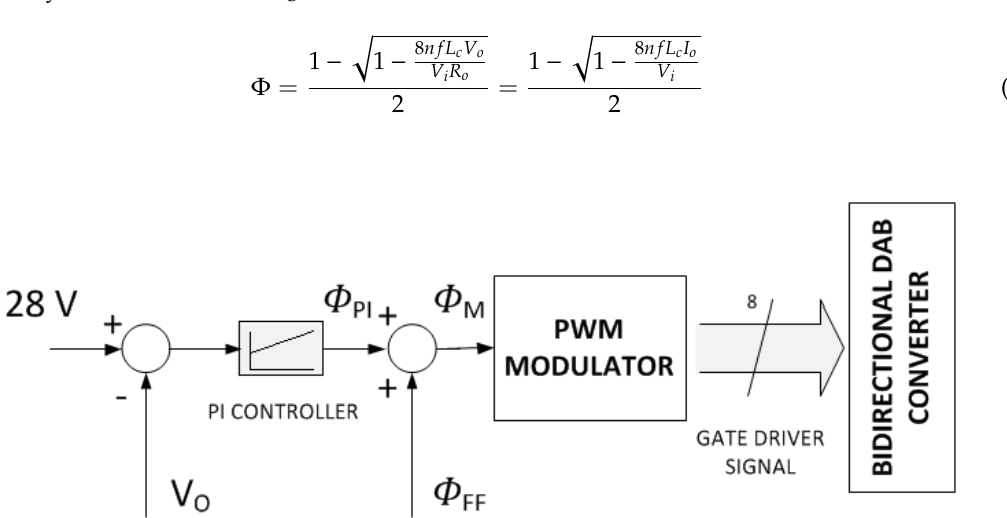
Figure 7. Converter control scheme with both a feedback and a feed-forward loop.